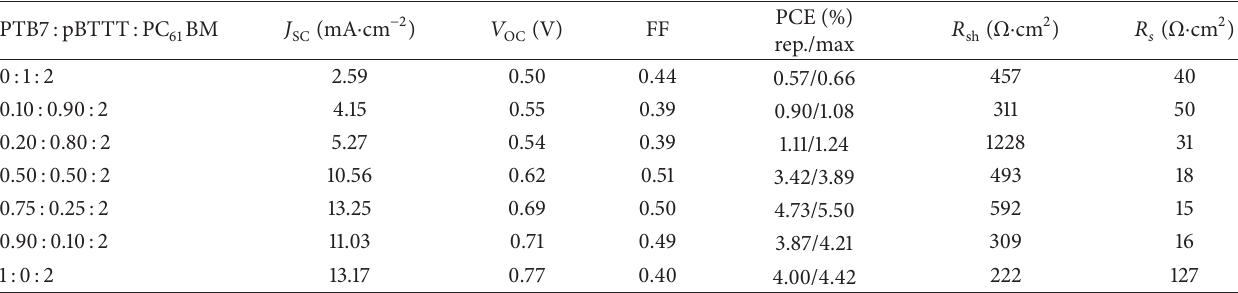
Table 1: Performance parameters of representative curves and maxima PCE values of the OPV cells.